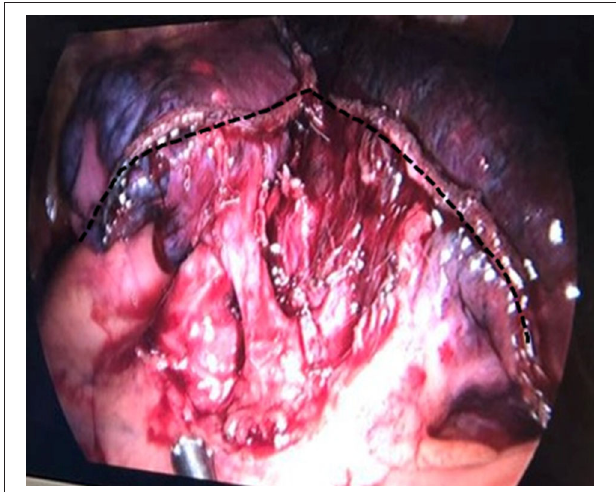
FIGURE 1 | Dotted line demonstrates that after left anterior segmentectomy, most conventional segmental planes are like a triangle.